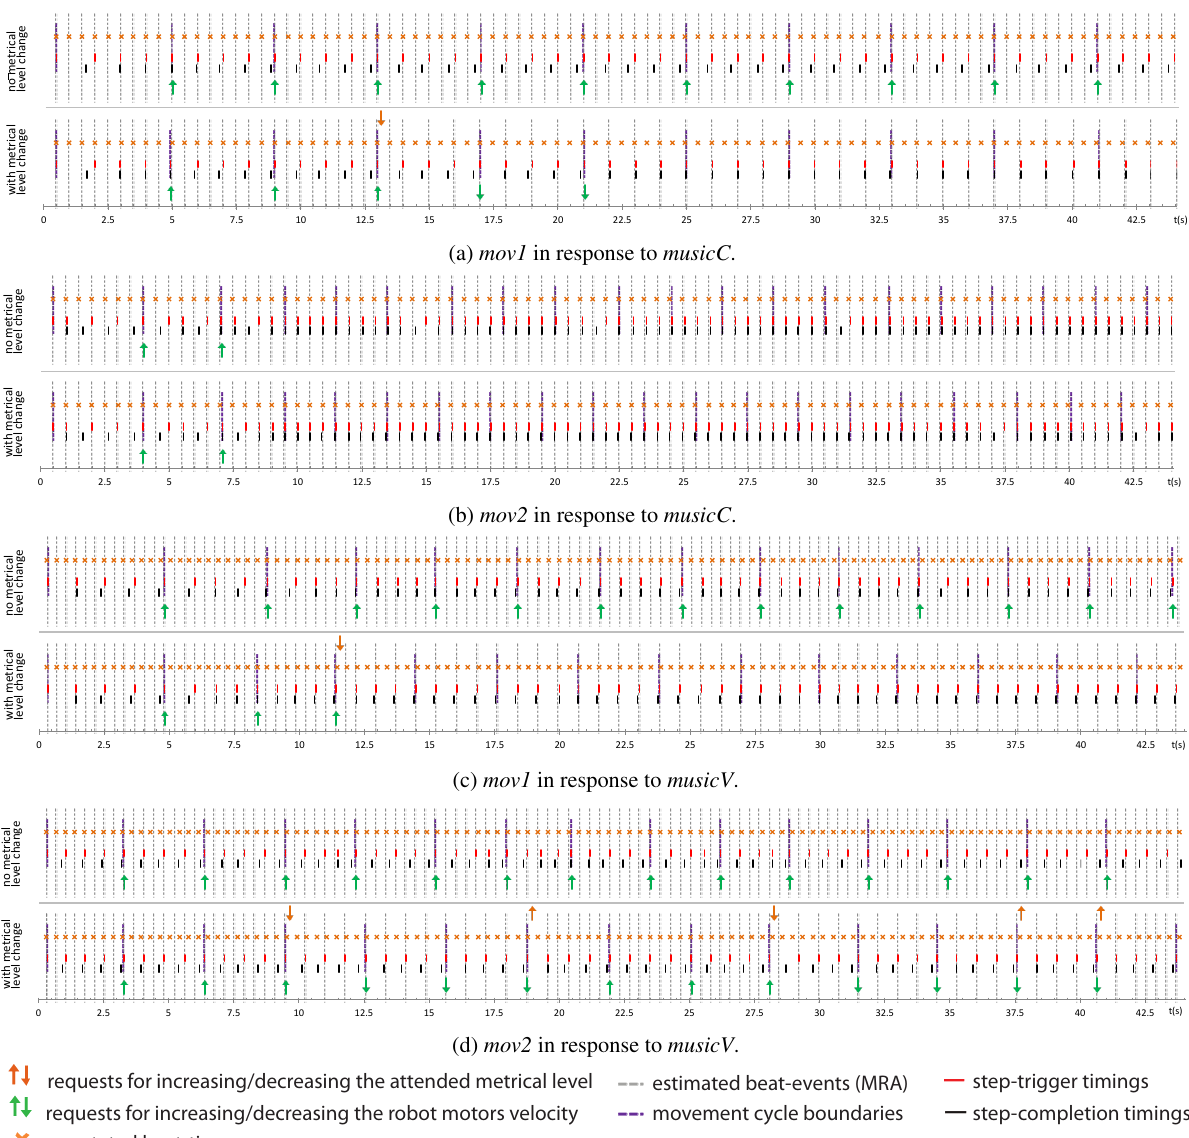
Figure 6: Visualization of the beat-synchrony of four robot dance sequences performed by concatenating successive cy- cles of the same movement: mov1 – (a), (c) or mov2 – (b), (d); in online response to different musical stimuli: musicC – (a), (b) and musicV – (c), (d); by (top graph) and without (bottom graph) applying metrical-level changes. The beat-events estimated by the MRA are signed by full gray dashed lines; the triggered step transition timings by the upper red bars and their respective completion by the lower black bars; the movement cycles are demarcated by the long purple dashed lines; the annotated beat-times by orange crosses; the requests for increasing/decreasing the robot motors velocity by the lower up/down green arrows; and the requests for increasing/decreasing the metrical-level by the upper up/down orange